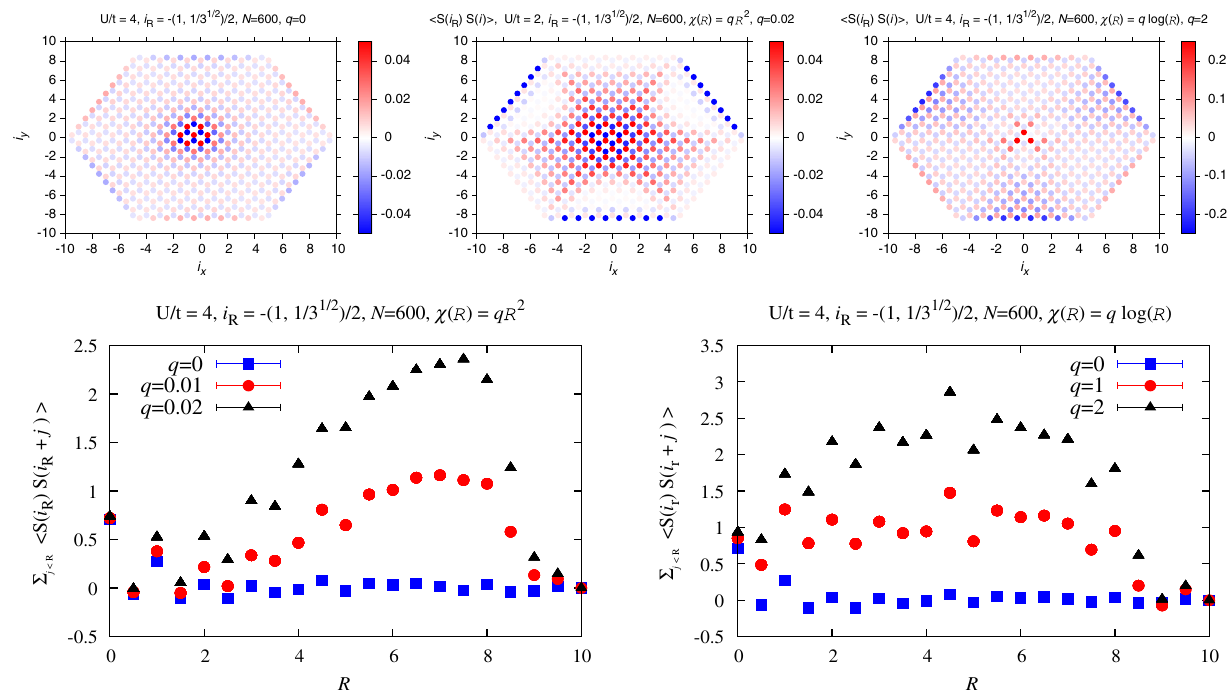
FIG. 7. Quantum Monte Carlo simulations on a 600-site flake. Top panels: Spin-spin correlation functions between the reference point ffiffiffi p i ¼ ð − 1 = 2 ; − 1 = 2 3 Þ and other sites of the lattice in the absence of axial field [ χ ð R Þ ¼ 0 ] (left), and in the presence of uniform R [ χ ð R Þ ¼ q R 2 ] (middle) and local [ χ ð R Þ ¼ q log ð R Þ ] (right) axial fields. Bottom panels: Integrated spin-spin correlations S ð R Þ [see Eq. (12)] at U=t ¼ 4 for the uniform χ ð R Þ ¼ q R 2 (left) and local χ ð R Þ ¼ q log ð R Þ (right) axial